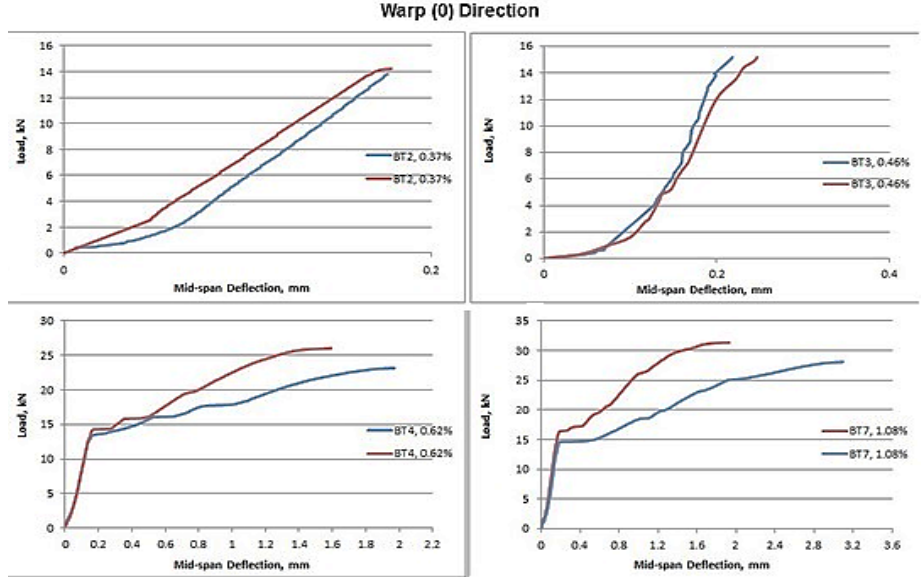
Figure 6. Mid-span load-deflection of TRC beams with woven fabric (2.5 cm) in the warp direction.